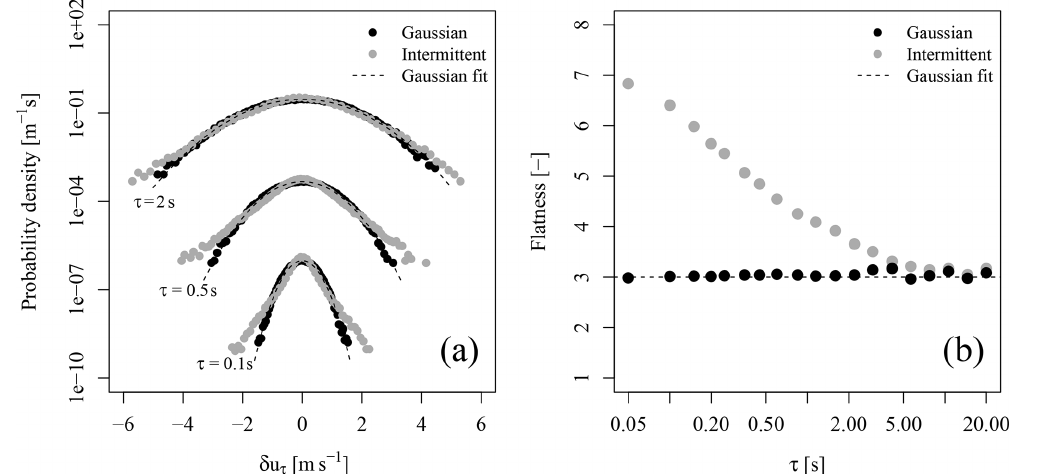
Figure 5. Comparison of the two-point statistics for the Gaussian and intermittent fields. (a) Histograms of velocity increment time series for τ = 0 . 1, 0.5, 2s, shifted vertically for better representation. (b) Flatness of increment PDFs in the range 0.05s ≤ τ ≤